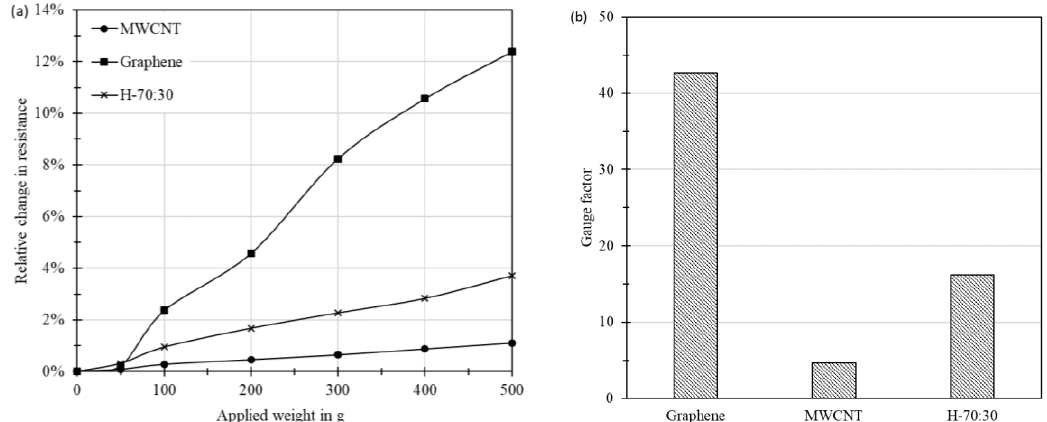
Figure 10. ( a ) Relative change in resistance with applied slotted weights, and ( b ) gauge factor comparison of the thin film strain sensors.